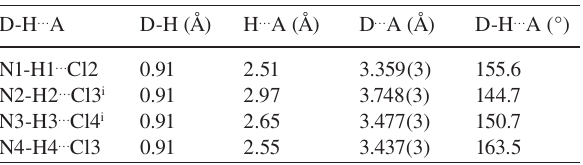
Table 2 Hydrogen bonding parameters ( Å , ° ) for [Cd II (L)( µ -Cl) ] ( 1 ). Cd II Cl 3